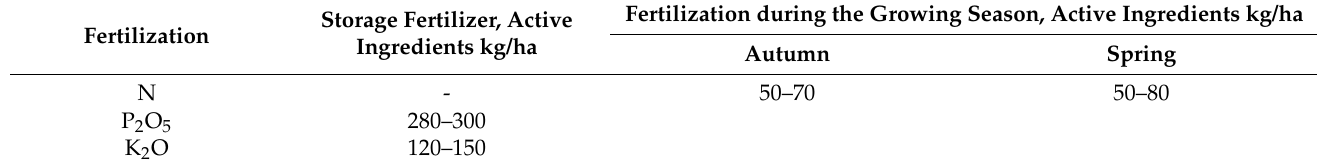
Table 2. Fertilization rates and